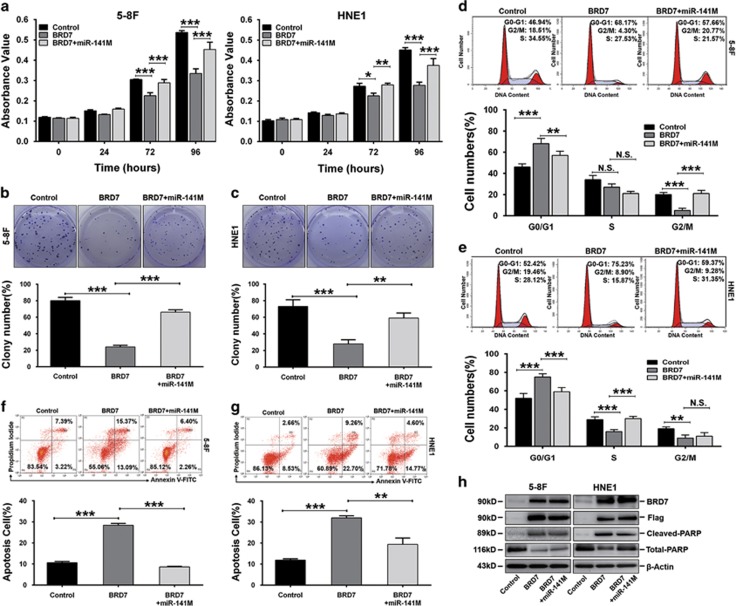
BRD7 inhibited cell proliferation and promoted apoptosis by downregulating miR-141 expression in 5-8F and HNE1 cells. (a) MTT assays of cells transfected with miR-141M or miR-NC. (b and c) Colony-forming assay images (upper panel) and quantification of colony number/well (lower panel). (d and e) Cell-cycle analysis by flow cytometry. (f and g) Annexin V-FITC and PI double staining analysis of cell apoptosis by flow cytometry. (h) Expression of the apoptosis marker c-PARP was determined by western blot. β-Actin served as an internal control. (a–g) The error bars are presented as the mean±S.E.M. Control: vector+miR-NC, BRD7: BRD7+miR-NC. **P<0.01, ***P<0.001, NS, no significance. All experiments were performed in triplicate